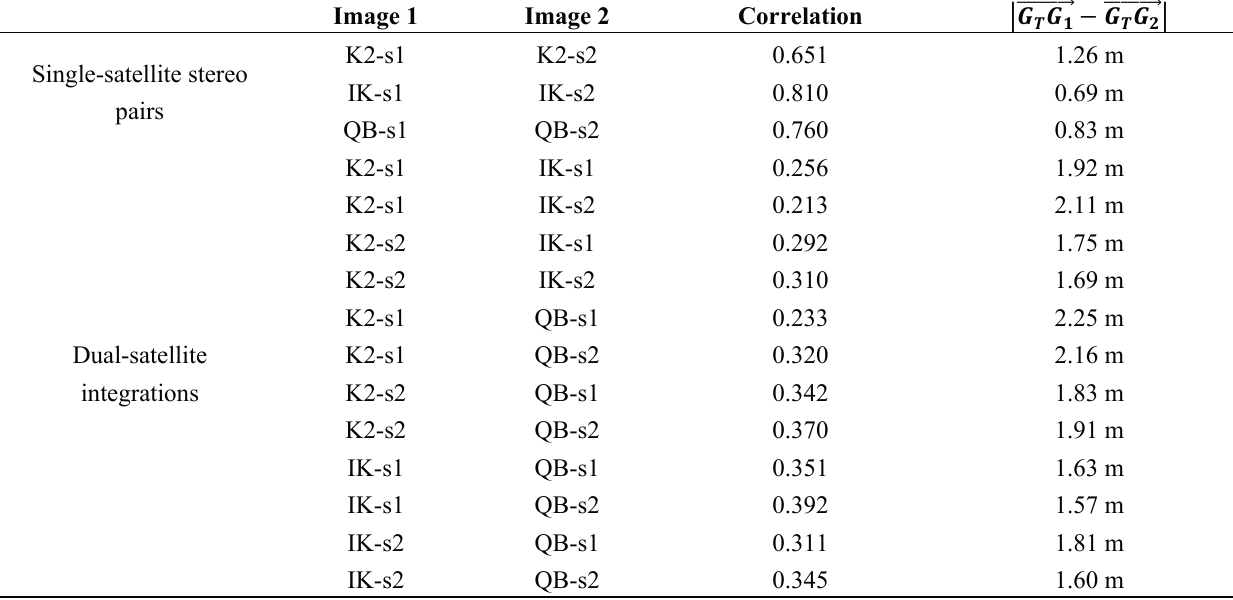
Table 5. Similarity of pointing error patterns for single-satellite stereo and dual-satellite stereo (18